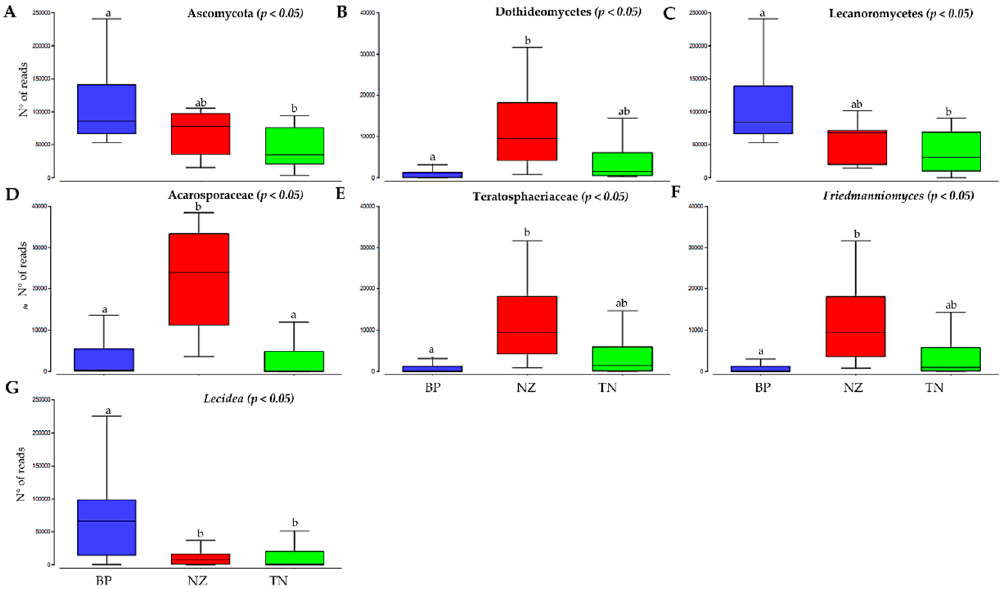
Figure 6. Relative abundance of Fungi. ( A ) Ascomycota phylum; ( B ) Dothideomycetes class; ( C ) Lecanoromycetes class; ( D ) Acarosporaceae family; ( E ) Teratosphaeriaceae family; ( F ) Friedmanniomyces genus; ( G ) Lecidea genus. Boxplots show 25th and 75th percentile, while error bars 1st and 99th percentile. Same letters indicate that no significant differences occur among site, according to the one-way ANOVA Tukey HSD test ( p < 0.05).